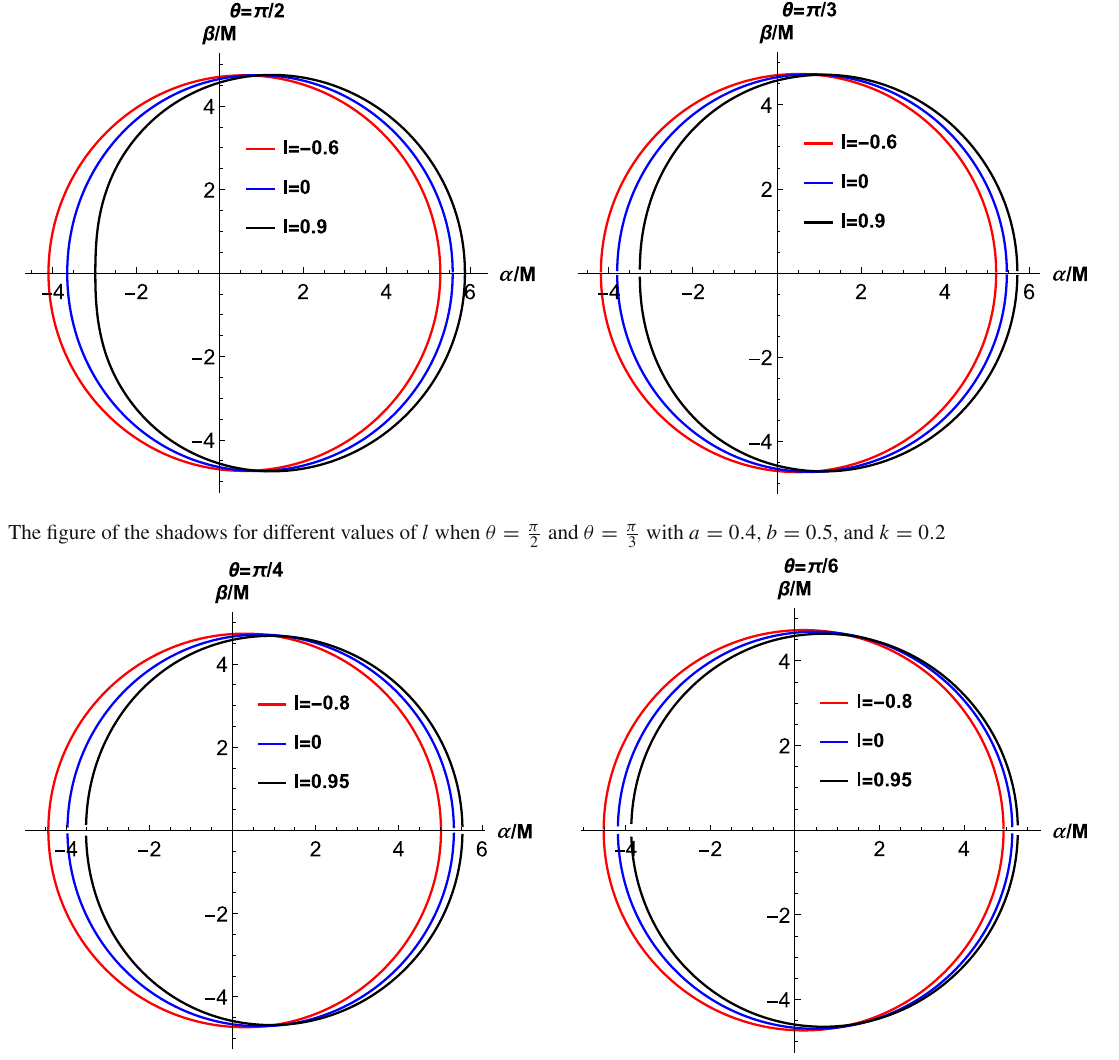
Fig. 8 The figure of the shadows for different values of l when θ = π